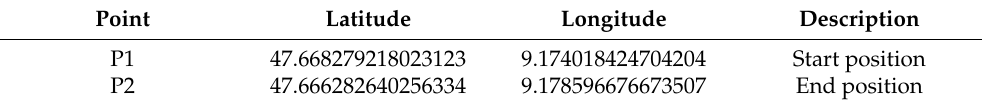
Table 3. Significant points specifying the application